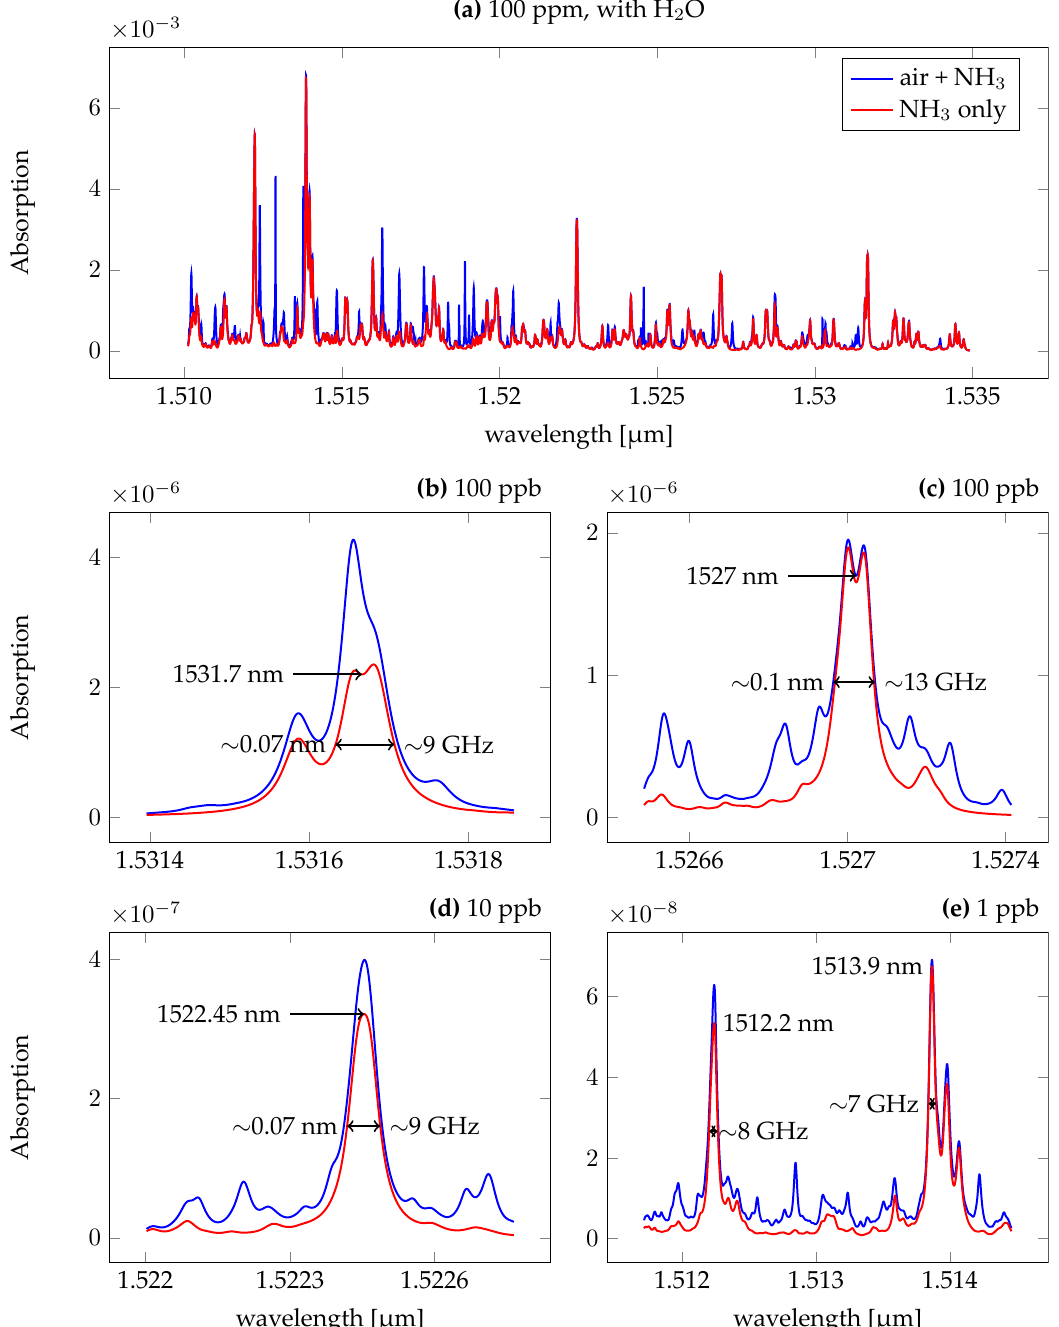
Figure 2. Absorption spectra for ambient air mixed with NH 3 . ( a ) Overview of the available absorption lines. The red line shows the contribution of the 100 ppm added NH 3 to the total absorption spectrum, which itself is shown in blue. The majority of the interfering signal is caused by water vapour. ( b – e ) After the removal of water, different absorption lines can be exploited for spectroscopic purposes. While the strength of all the lines is comparable, the overlap with other lines as well as the distance to the design wavelength of the on-chip laser can make certain lines more favourable compared to others. The sensitivity limits due to line overlap are shown in Figure